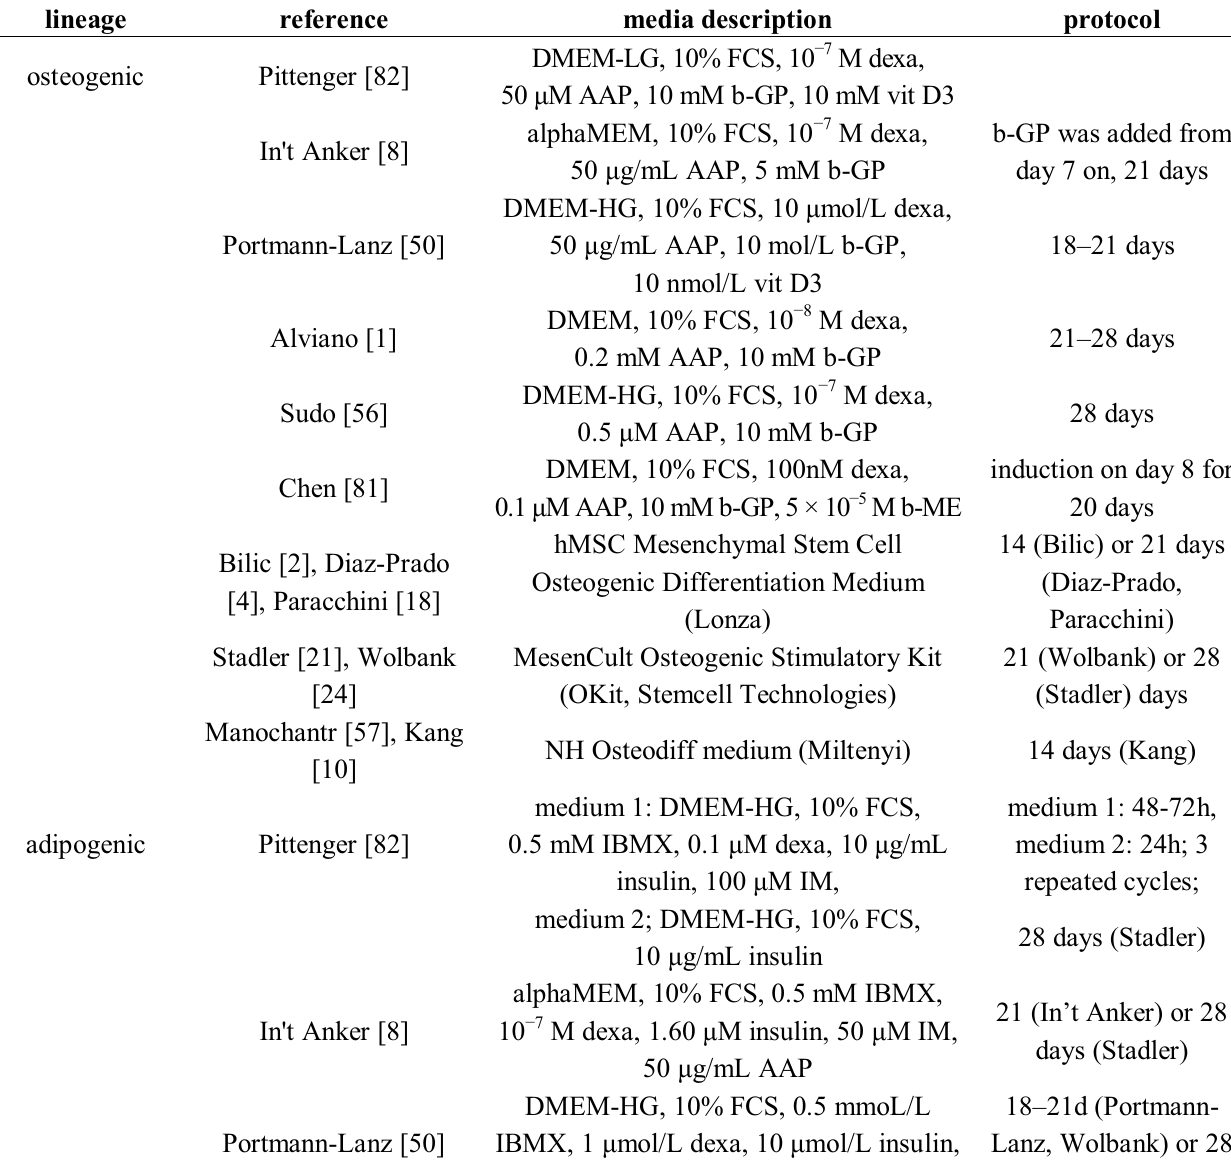
Table 2. Media used for differentiation (cid:82)(cid:73)(cid:3) (cid:75)(cid:36)(cid:48)(cid:54)(cid:38)(cid:30)(cid:3) (cid:36)(cid:69)(cid:69)(cid:85)(cid:72)(cid:89)(cid:76)(cid:68)(cid:87)(cid:76)(cid:82)(cid:81)(cid:86)(cid:29)(cid:3) (cid:39)(cid:48)(cid:40)(cid:48)(cid:3) (cid:39)(cid:88)(cid:79)(cid:69)(cid:72)(cid:70)(cid:70)(cid:82)(cid:182)(cid:86)(cid:3) (cid:80)(cid:82)(cid:71)(cid:76)(cid:73)(cid:76)(cid:72)(cid:71)(cid:3)(cid:40)(cid:68)(cid:74)(cid:79)(cid:72)(cid:86)(cid:182)(cid:86)(cid:3)(cid:80)(cid:72)(cid:71)(cid:76)(cid:88)(cid:80)(cid:15)(cid:3)(cid:47)(cid:41)(cid:3)(cid:79)(cid:82)(cid:90)(cid:3)(cid:74)(cid:79)(cid:88)(cid:70)(cid:82)(cid:86)(cid:72)(cid:15)(cid:3)(cid:43)(cid:42)(cid:3)(cid:75)(cid:76)(cid:74)(cid:75)(cid:3)(cid:74)(cid:79)(cid:88)(cid:70)(cid:82)(cid:86)(cid:72)(cid:15)(cid:3)(cid:41)(cid:38)(cid:54)(cid:3)(cid:73)(cid:72)(cid:87)(cid:68)(cid:79)(cid:3)(cid:70)(cid:68)(cid:79)(cid:73)(cid:3)(cid:86)(cid:72)(cid:85)(cid:88)(cid:80)(cid:15)(cid:3)(cid:71)(cid:72)(cid:91)(cid:68)(cid:3) dexamethasone, AAP ascorbic acid or ascorbat-2-phosphate, b-GP